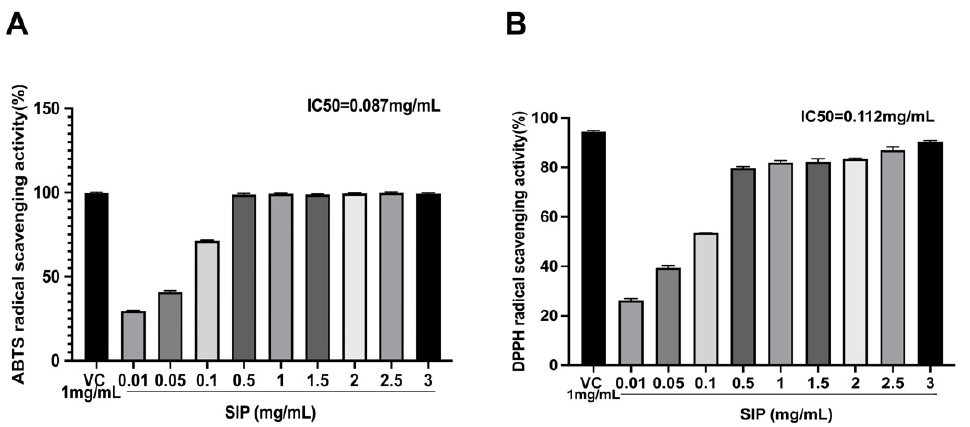
Figure 1. ( A ) ABTS radical scavenging activity of SIP. ( B ) DPPH radical scavenging activity of SIP. Results were presented as the mean ± SD ( n = 6).